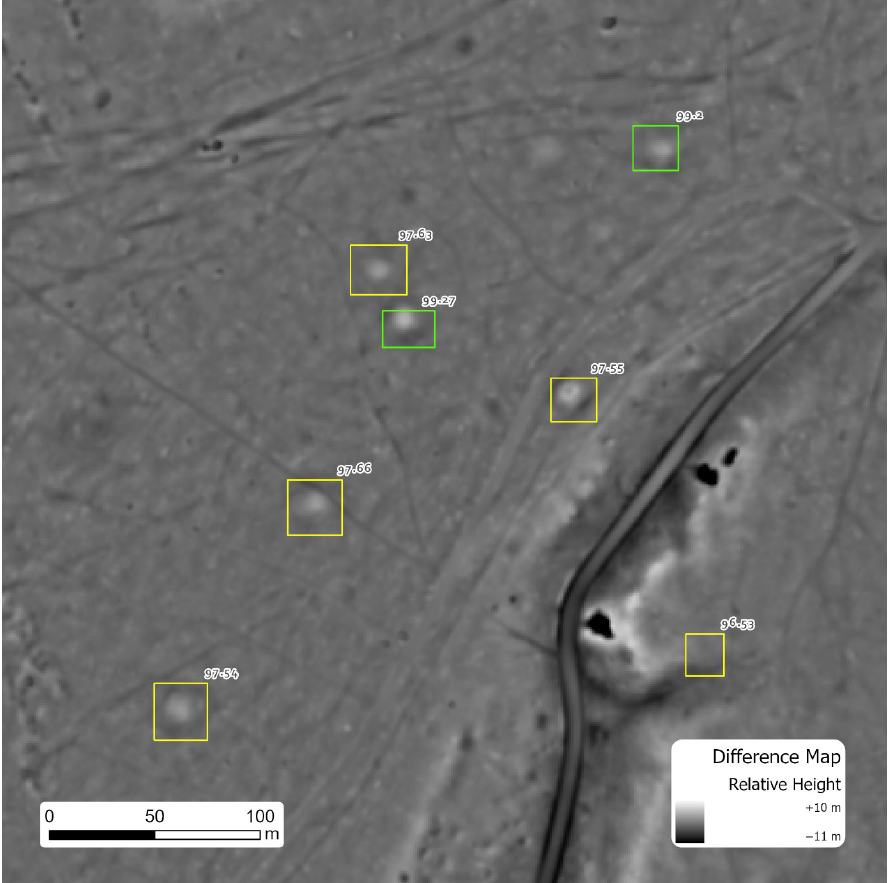
Figure 11. Detected burial mounds in direct proximity to a hollow way (top). Green polygons represent true positives. Yellow polygons represent detections that were filtered out during post classification as their confidence was too low. Lowering the confidence threshold would have included them, however, too many false positives would have been included as well. Data source: [25]. Finally, the number of detected mounds in areas defined by radii of 500 m to 3000 m around each hollow way was calculated (Figure 12 and Table 1).